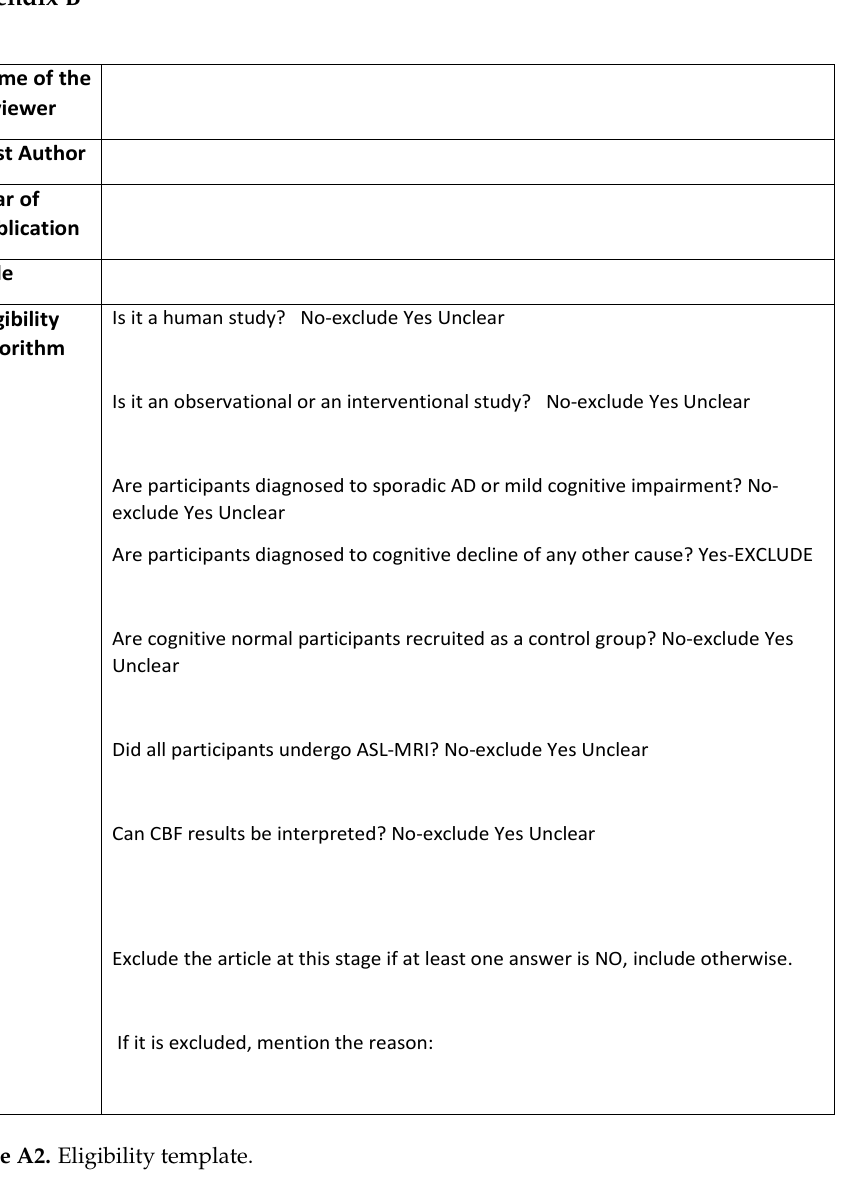
Figure A1. Full search strategy.